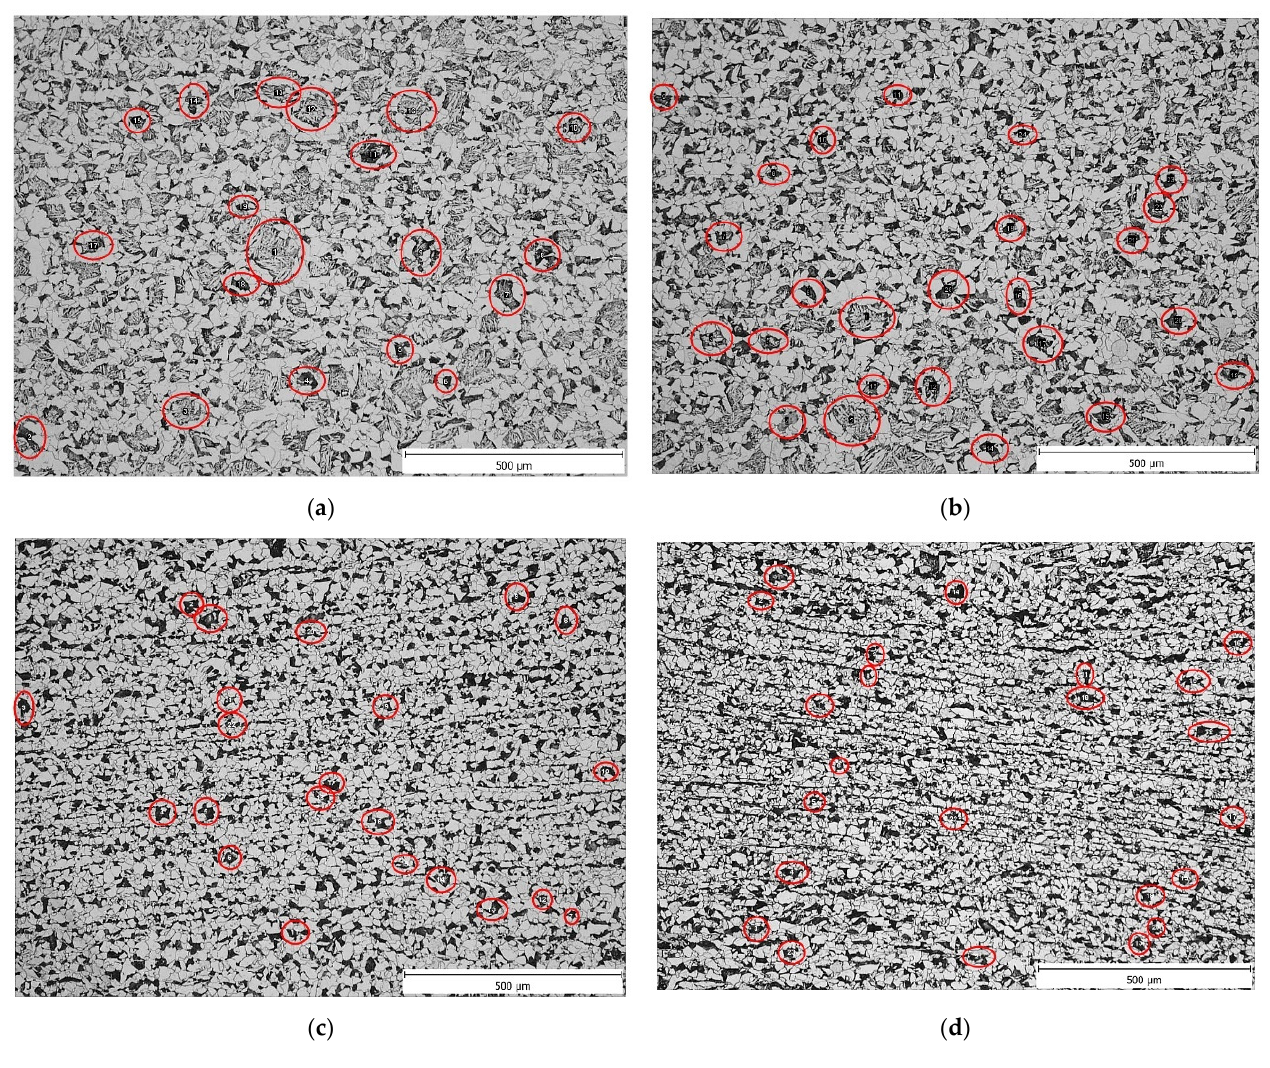
Figure 16. Comparison of the resulting microstructure in the centre of the samples for all variants. V1 and V2—a mixture of allotriomorphic ferrite, acicular ferrite and pearlite; V3 and V4—a mixture of allotriomorphic ferrite and pearlite. The red ellipses indicate the maximum size of the original austenitic grain. ( a ) Variant 1, region B, deformed part; ( b ) variant 2, region B, deformed part; ( c ) variant 3, region B, deformed part; and ( d ) variant 4, region B, deformed